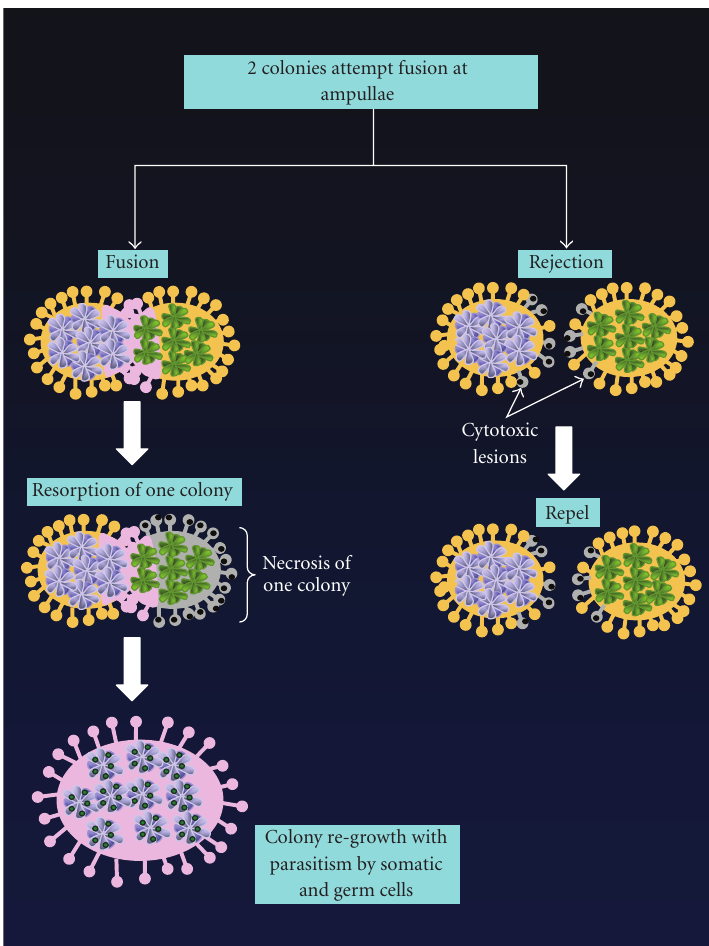
Figure 2: Botryllus schlosseri colony interactions. In the wild, colonies of B. schlosseri can become quite large, and genetic analyses reveal these colonies to be multichimeric. Interactions between genetically distinct colonies are governed by an allorecognition system controlled by the fusibility/histocompatibility locus (Fu/HC). When genetically distinct colonies contact one another, they will anastamose if one or both Fu/HC loci are recognized as self. Fusion involves the creation of a shared vasculature and common tunic. If neither Fu/HC loci are shared, rejection will occur and inflammatory lesions will develop at sites of contact. One colony will be largely resorbed after acceptable recognition and successful colony fusion, although some germ and somatic cells of the resorbed individual will persist in the survivor, creating a parasitic